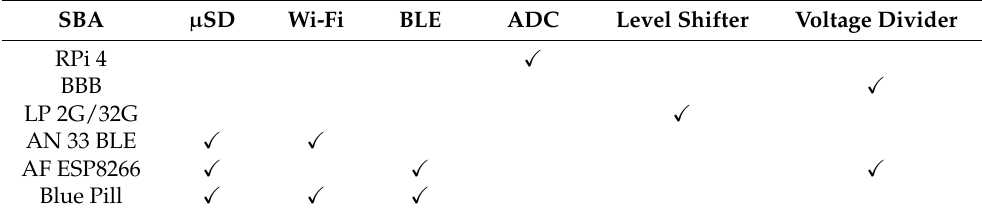
Table 11. Modules used with each SBAs in experimental